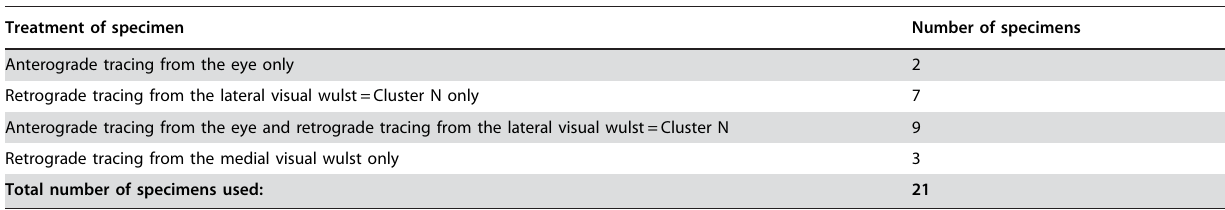
Table 1. Overview of tracer application sites and number of specimens used. .. ... .... ... ... .... ... ... .... ... ... .... ... ... .... ... ... .... ... ... .... ... ... .... ... ... .... ... ... .... ... ... .... ... ... .... ... ... .... ... ... .... ... ...